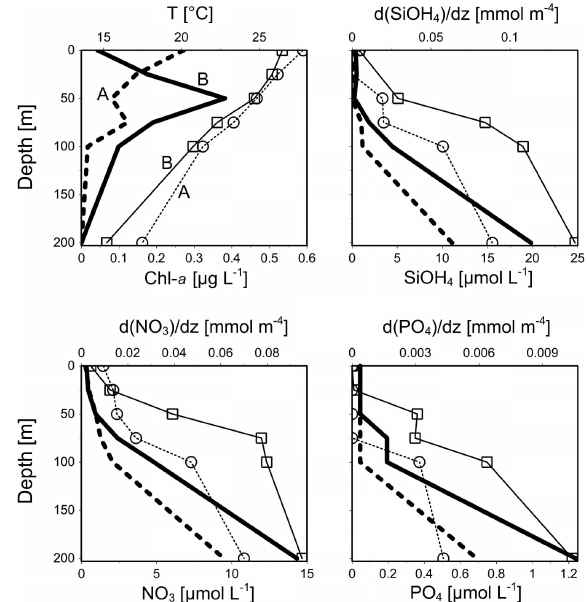
Figure 6. Comparisons of vertical profiles of chlorophyll a (Chl a ), temperature ( T ), nutrients (Si(OH) 4 , NO 3 , PO 4 ), and nutrient gra- dients between two incubation stations A and B. Thick lines in each panel are for bottom axis with thin lines (open symbols) for top axis; dashed lines are for station A with solid lines for station